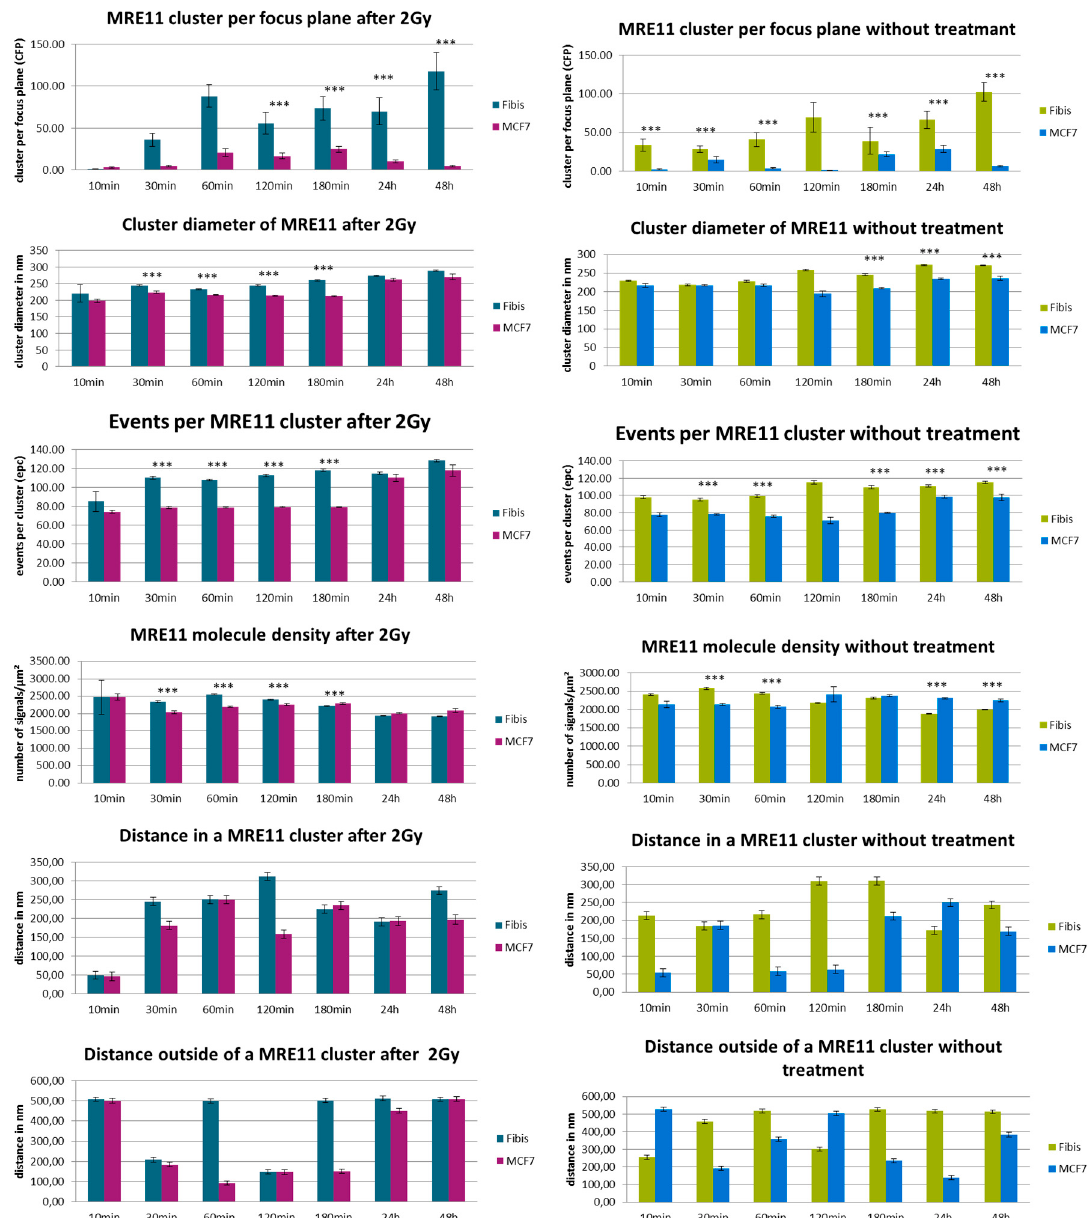
nuclei each. The error bars on top of the column indicate the standard deviation. For each time step after the irradiation process, the data are given for cells exposed to 2 Gy low LET ionizing radiation (“2 Gy”) and for cells subjected to the same culturing procedure but not to radiation treatment (“w/o”). Level of significance between the corresponding values for “2 Gy” and “w/o”: *** = 0.1%; ** = 1%. For further details see text.